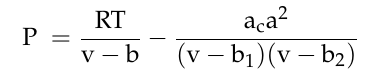
Figure 5. Flow chart of the methodology analysis.